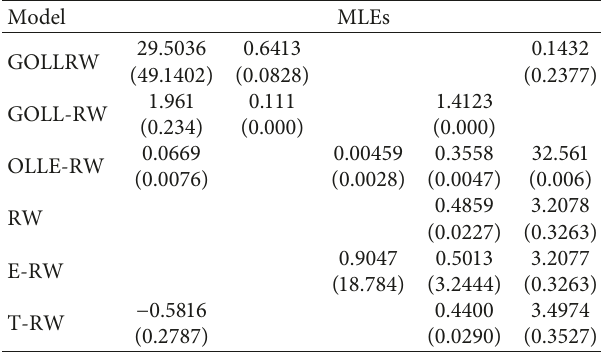
Table 13: MLEs (SEs) for relief time data set.